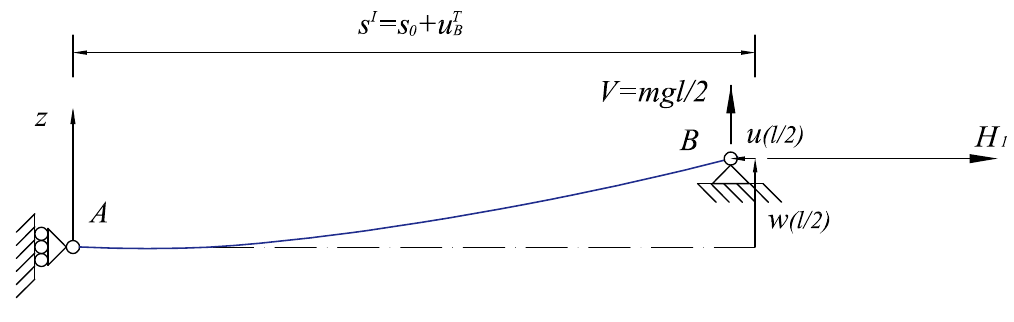
Figure 7. Final static state. Fixed point B .